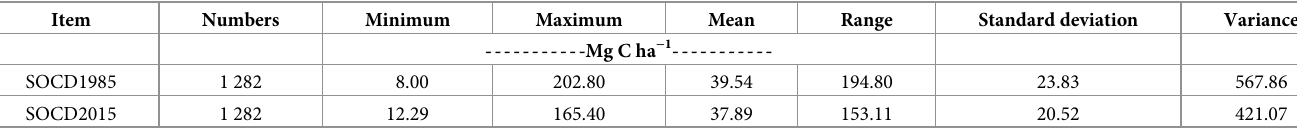
Table 2. SOCD descriptive statistics for 1985 and 2015. Item